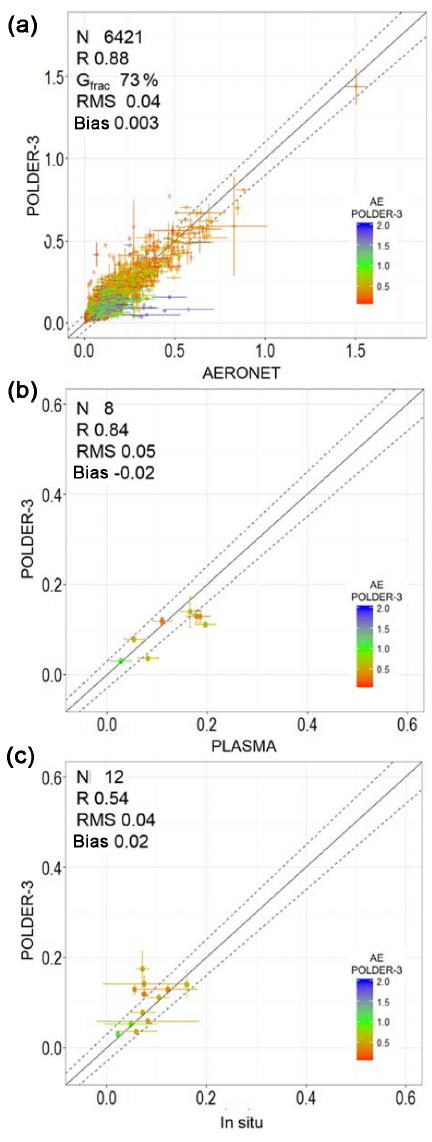
Figure 3. Scatter plots of daily AOD retrieved by POLDER-3 at 865nm with respect to (a) coincident and co-located values from the 17 ground-based AERONET sites at 870nm; (b) airborne PLASMA sun-photometer operated at 865nm during ADRIMED; and (c) results of the optical calculations at 865nm accord- ing to Fig. 1 from airborne measurements during TRAQA and ADRIMED. The solid line is the bisector. The dashed lines repre- sent the limits indicated by the G frac parameter. The characteristics of the linear correlation (number of points N , correlation coefficient R , G frac , RMSE, and bias) are also reported.